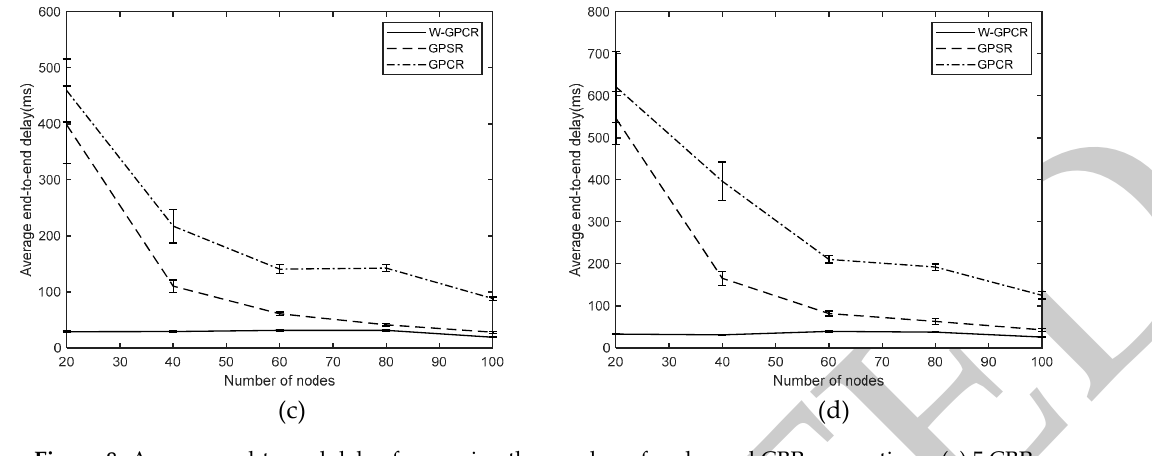
Figure 8. Average end-to-end delay for varying the number of nodes and CBR connections: ( a ) 5 CBR connections; ( b ) 10 CBR connections; ( c ) 15 CBR connections; ( d ) 20 CBR connections.